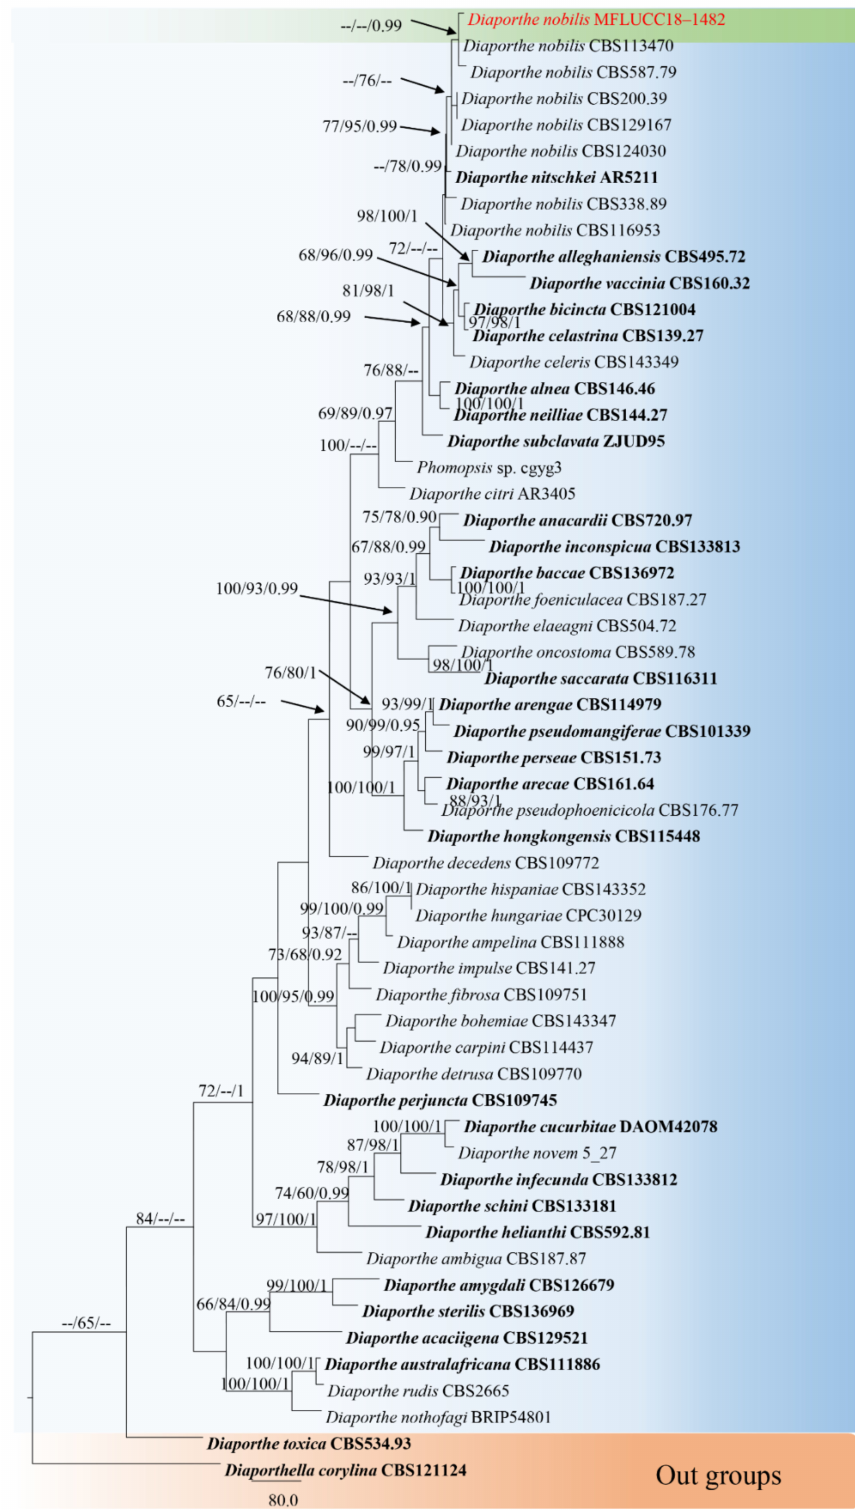
Figure 3. RAxML tree based on a combined dataset of ITS, TEF1 and TUB2 gene regions. Bootstrap support values for ML and MP equal to or greater than 60% and Bayesian posterior probabilities (PP) equal to or greater than 0.90 are defined as ML/MP/PP above or below the nodes. Our new taxon is indicated in red. The tree was rooted with Diaporthella corylina (CBS